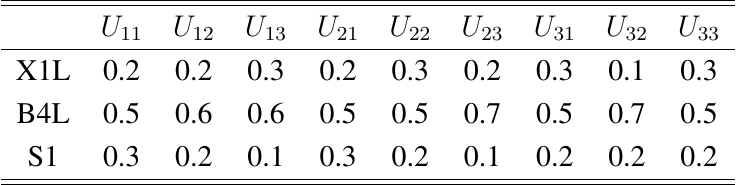
Table 6. The grade of